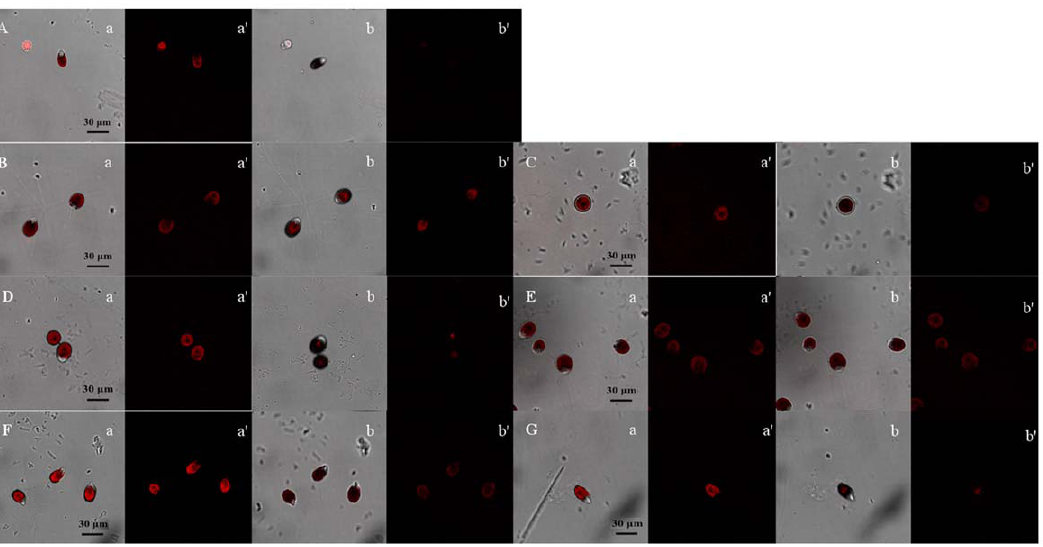
Figure 2. Images of D.salina treated by Ca 2 + channel blockers under hypoosmotic or hyperosmotic stress. The fluorescence of Ca 2 + in cell loaded with fluo-3 AM was excited by argon laser (excitation wavelength 488 nm, emission wavelength 525 nm), and the fluorescence of Ca 2 + in pictures were set to be red by soft LAS AF 2.1.1 build 4443 for observation. A: 2.0 M NaCl; B: 0.5 M NaCl; C: LaCl 3 + 0.5 M NaCl; D: RR + 0.5 M NaCl; E: VP + 0.5 M NaCl; F: 4.5 M NaCl; G: LaCl 3 + 4.5 M NaCl; H: RR + 4.5 M NaCl; I: VP + 4.5 M NaCl. a: Image of cell shape with maximum fluorescence; a 9 : Fluorescence image of cell with maximum fluorescence; b: Image of cell shape with minimum fluorescence; b 9 : Fluorescence image of cell with minimum fluorescence. All figures are representative of three replicated studies with similar findings.